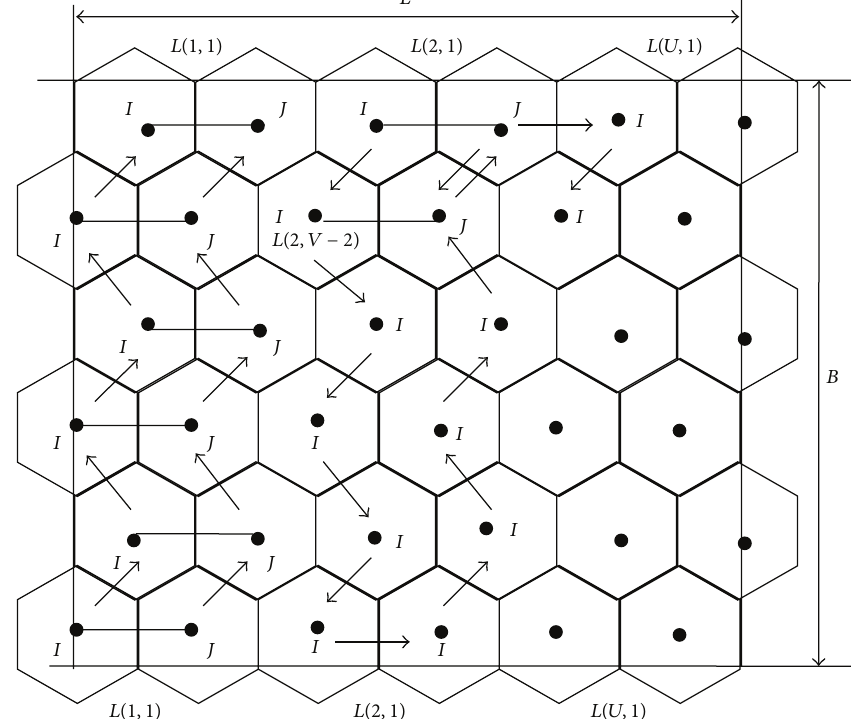
Figure 7: Failure of MSN in line based